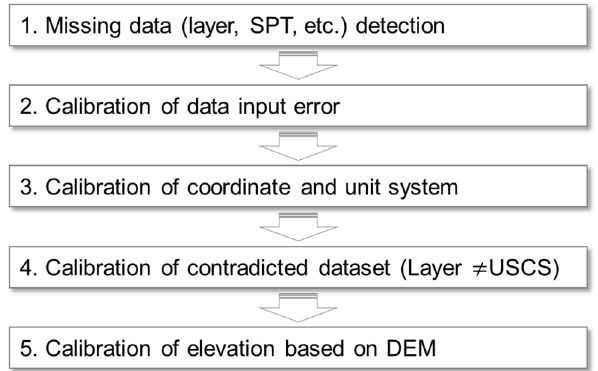
Figure 3. Schematic showing procedures of geospatial characterization for regional seismic site Figure 3. classification.